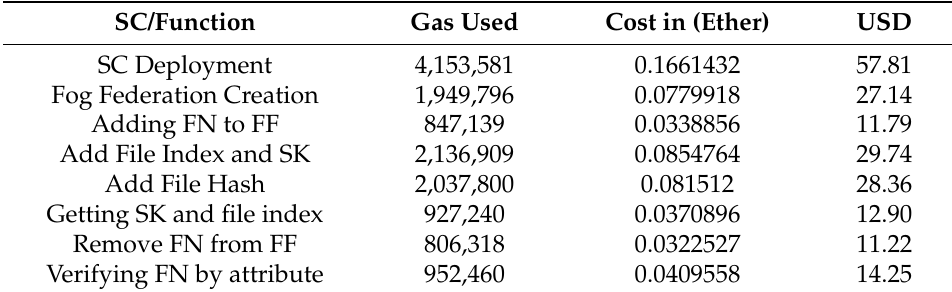
Table 4. Smart contract and functions test